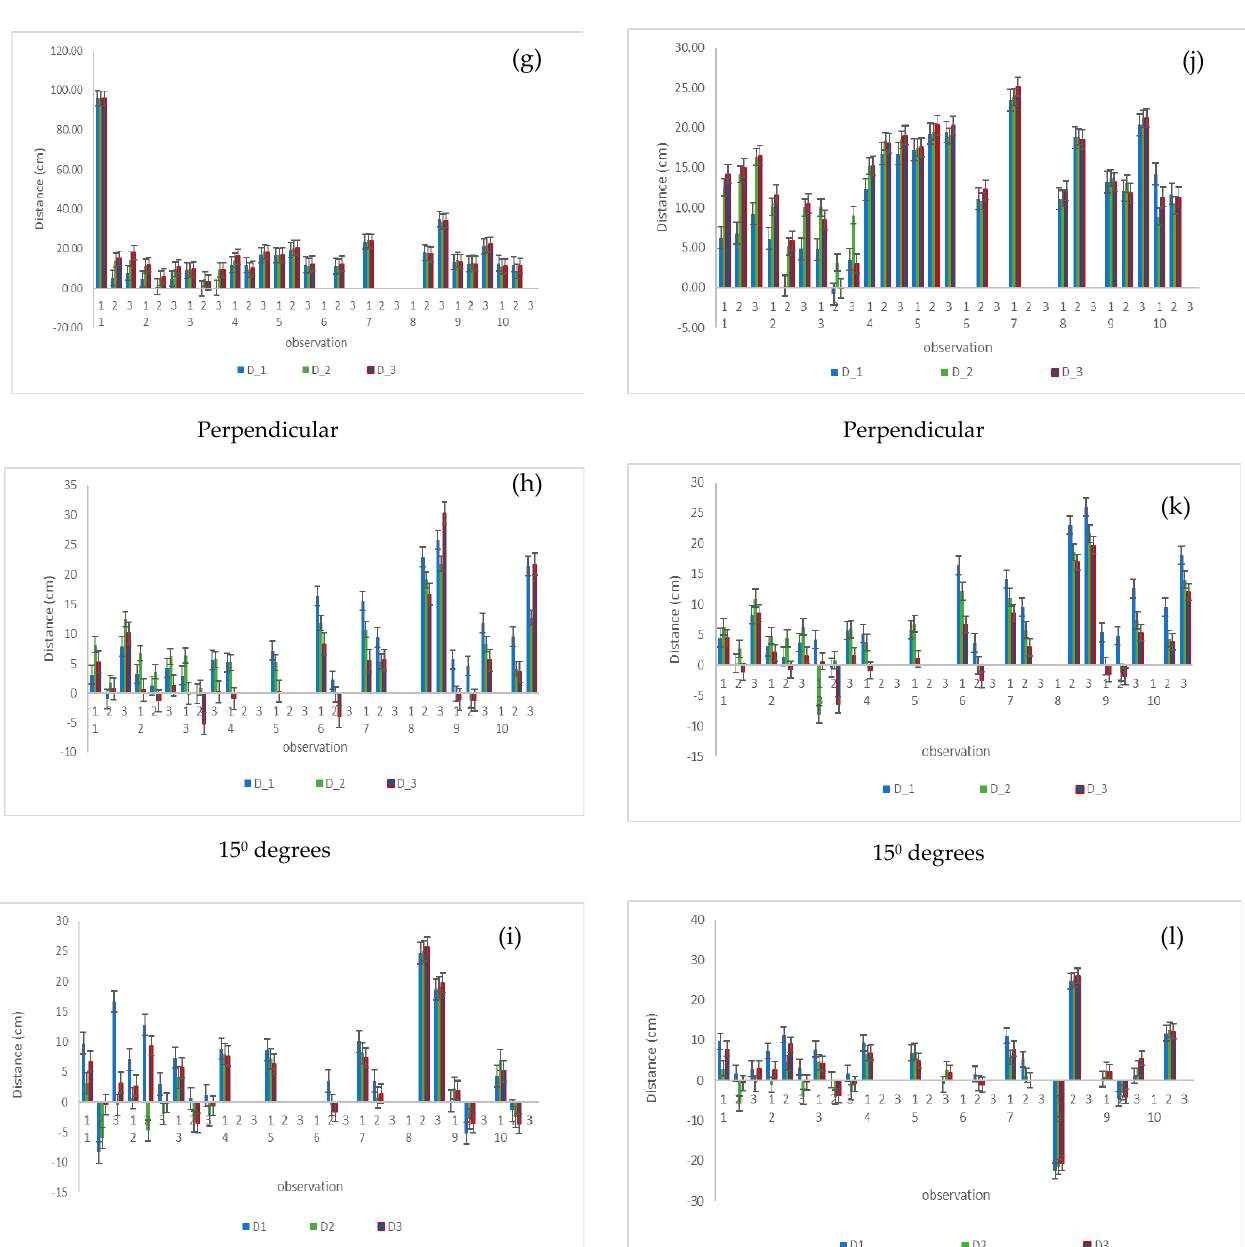
Figure A1. Difference between the real distance and the measured distance at three different speeds and three different angles. ( a – c ): YOLOv7 Deep SORT; ( d – f ): YOLOv5 Deep SORT; Difference between the real distance and the measured distance in three different speeds and three different angles. ( g – i ): YOLOv4 Deep SORT; ( j – l ): EfficientDet Deep SORT; D1, D2, D3 are difference between the measured depths value and the 3D-camera-detection depths value at speed of 0.052 ms − 1 , 0.069 ms − 1 and 0.098 ms − 1 respectively.